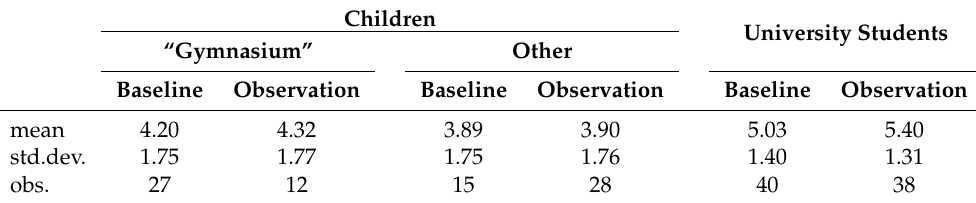
Table 1. Summary statistics with respect to urn choice.